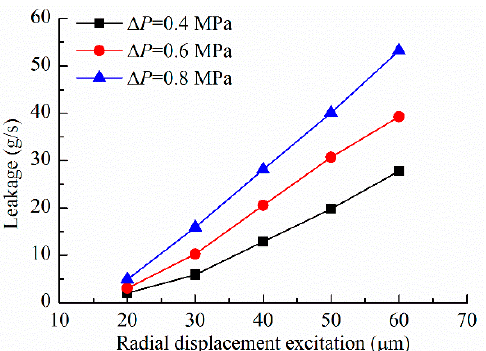
Figure 15. Effect of radial displacement excitation of rotor on the leakage of 2SFS.